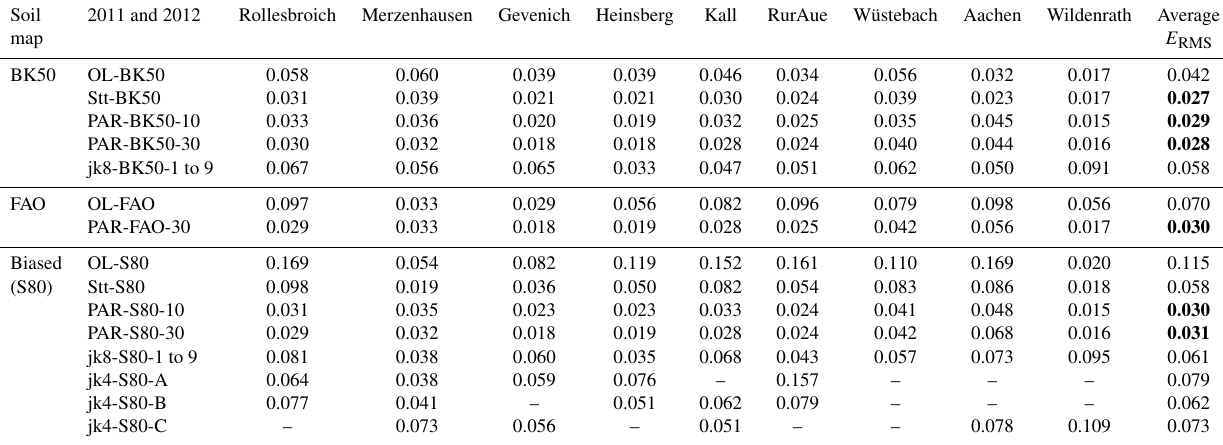
Table A1. E RMS (cm 3 cm − 3 ) at CRNS sites for open loop runs and different data assimilation scenarios, for the assimilation period (2011 and 2012). For jackknife experiments (21 in total) only the error of the omitted sites is reported. The best cases are marked in bold.